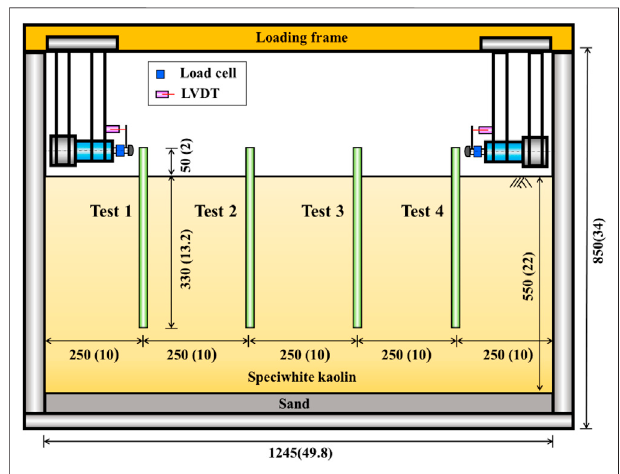
FIGURE 3 | Typical elevation view of the centrifuge model package for test 1-4. Note: All dimensions are in millimeters except for numbers in parentheses, which denote prototype scale (unit: